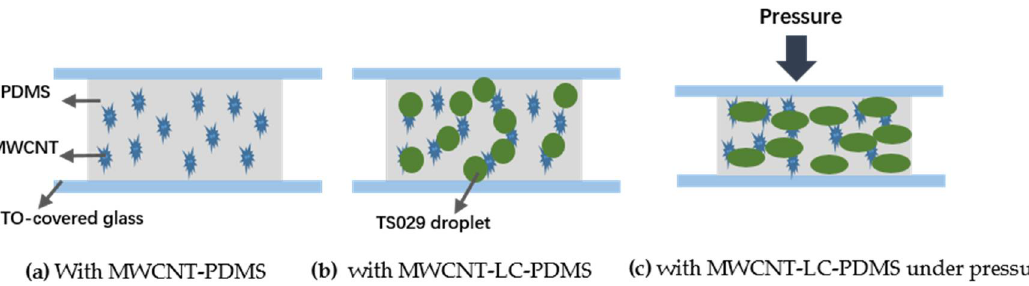
Figure 4. Schematic diagrams of the pressure sensor ( a ) with MWCNT-PDMS composite ( b ) with MWCNT-LC-PDMS composite ( c ) with MWCNT-LC-PDMS composite under applied pressure.